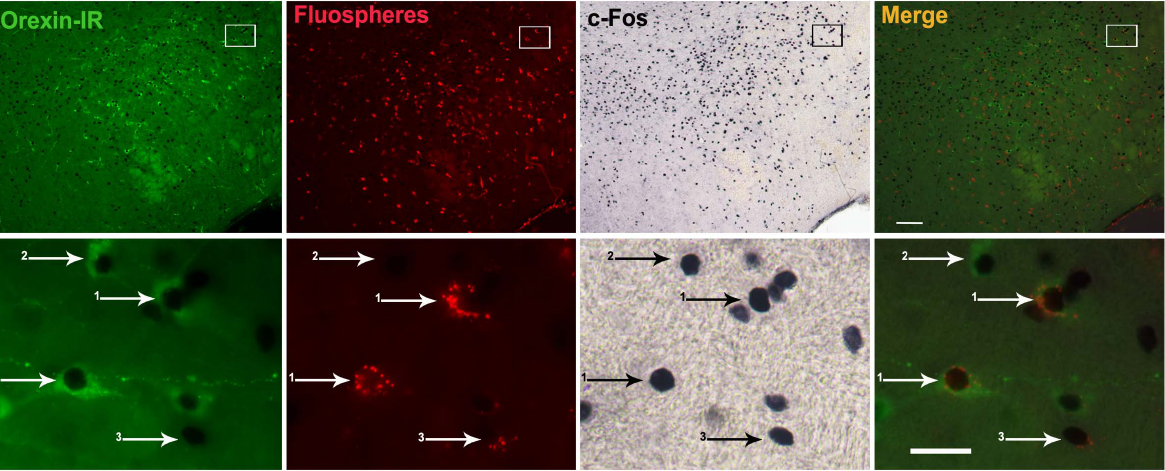
Figure 9. Acute HFD increases c-Fos in orexin neurons of the LHA projecting to the VTA. Upper sets of panels depict low magnification photomicrographs of the LHA of mice with stereotaxic injections of FluoSpheres in the VTA and allowed to eat HFD. Right column of images shows merge of orexin-IR (green fluorescent staining), FluoSpheres (red fluorescent), and c-Fos (black/purple staining) signals. Bottom set of panels show high magnification photomicrographs of the area marked in low magnification images. Numbered arrows point to labeled cells as follows: 1-triple- labeled cell; 2- double c-Fos/orexin-IR cell, negative for FluoSpheres; 3-double c-Fos/FluoSpheres cell, negative for orexin. Scale bars: 50 m m (Upper panels), 20 m m (Bottom panels).